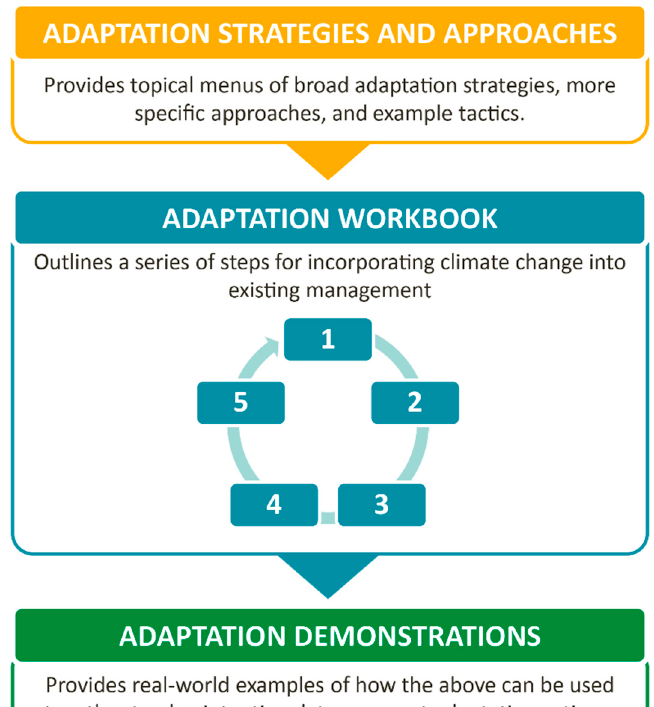
Figure 1. Adaptation tools within the CCRF. Figure reproduced with permission [10].